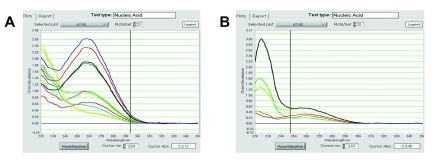
Representative graphical plots of total RNA extracted.(
A) PAXM: analysis of whole blood showed peaks positioned at 230 nm (n=10) and (
B) MP: analysis of PBMCs showed peaks positioned at 260 nm (n=5).